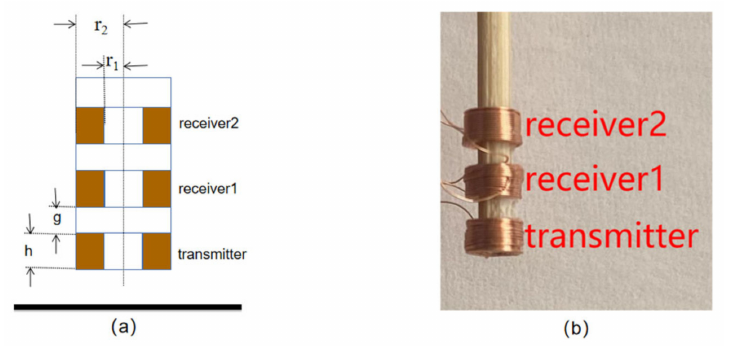
Figure 1. Sensor structure. ( a ) schematic ( b ) actual sensor. Table 1. Coil